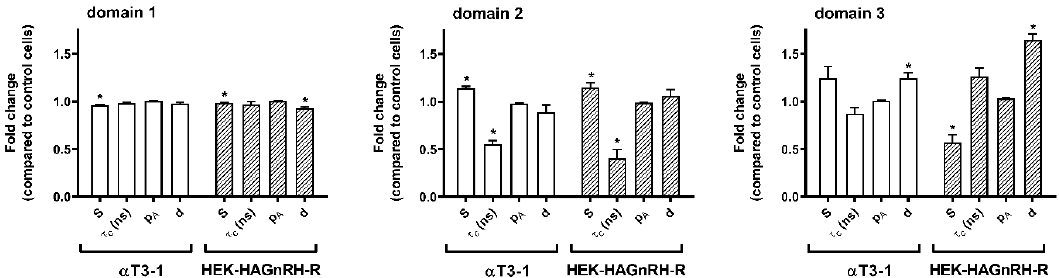
numbers correspond to the proportion of each domain type (%). GHOST diagrams are representative of at least four in-